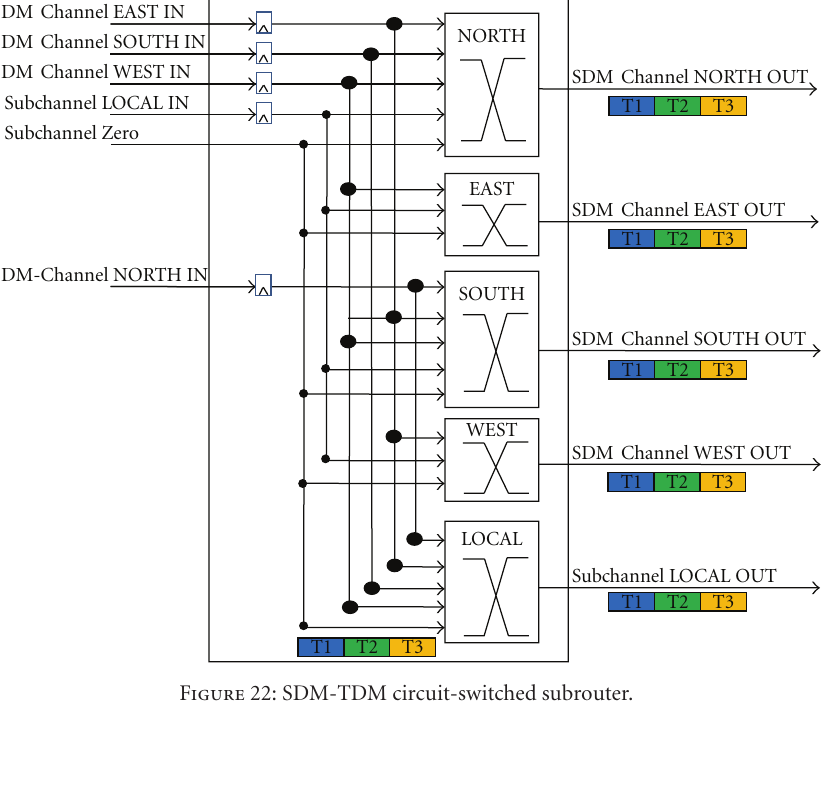
Figure 22: SDM-TDM circuit-switched subrouter.